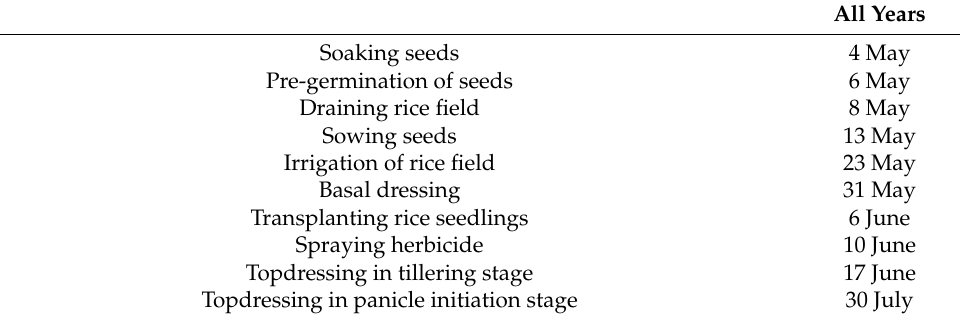
Table 1. Rice-cultivation schedule and climatic conditions each